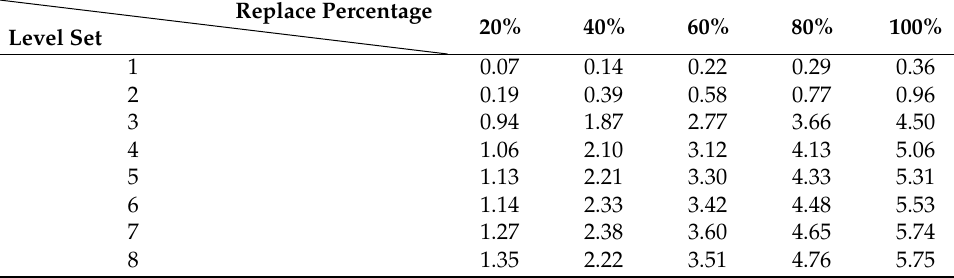
Table 10. Pressure error of substituting the 3rd